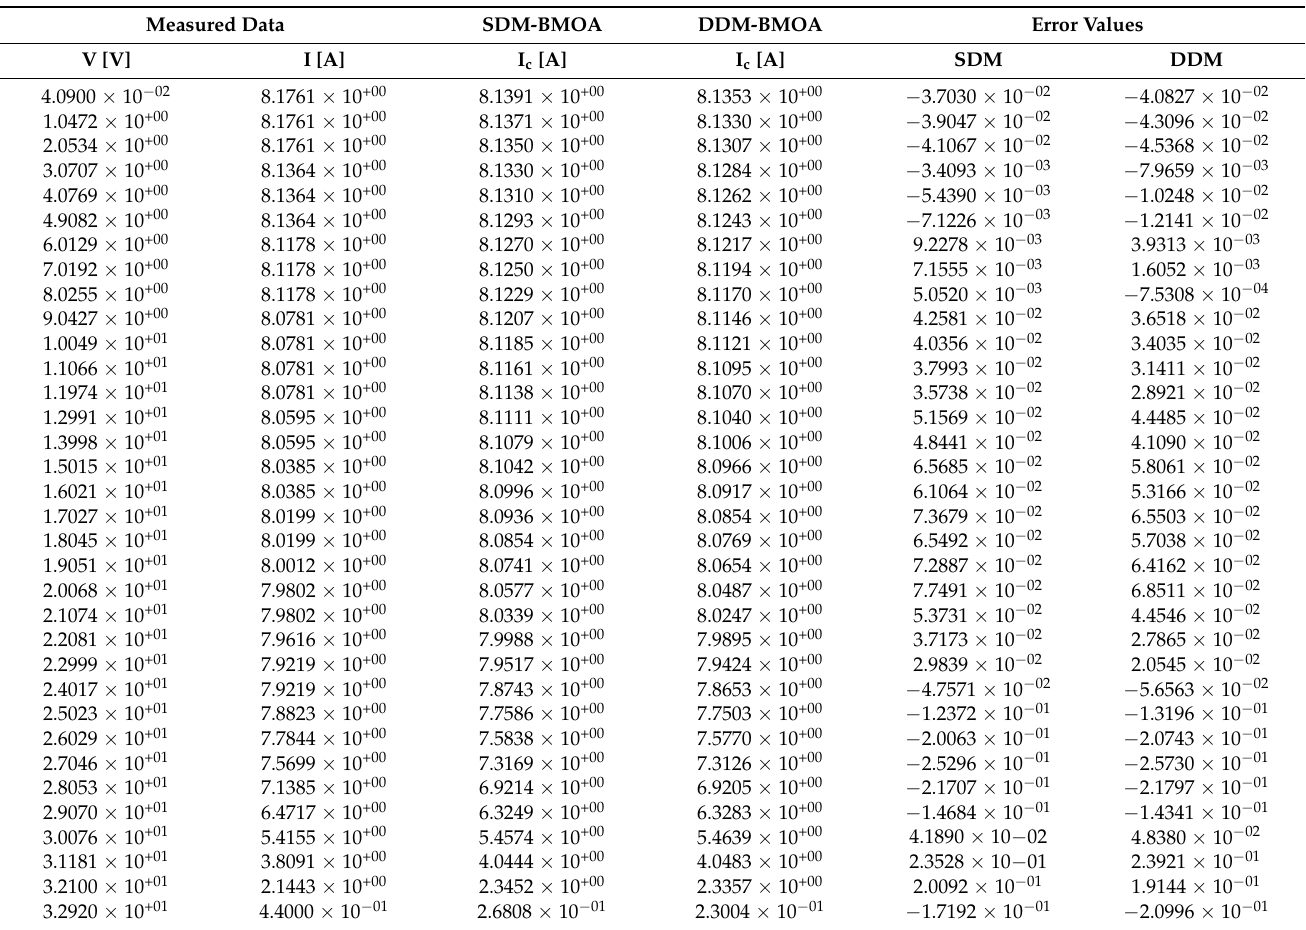
Table 17. (I, V) points of Kyocera KC200GT photovoltaic